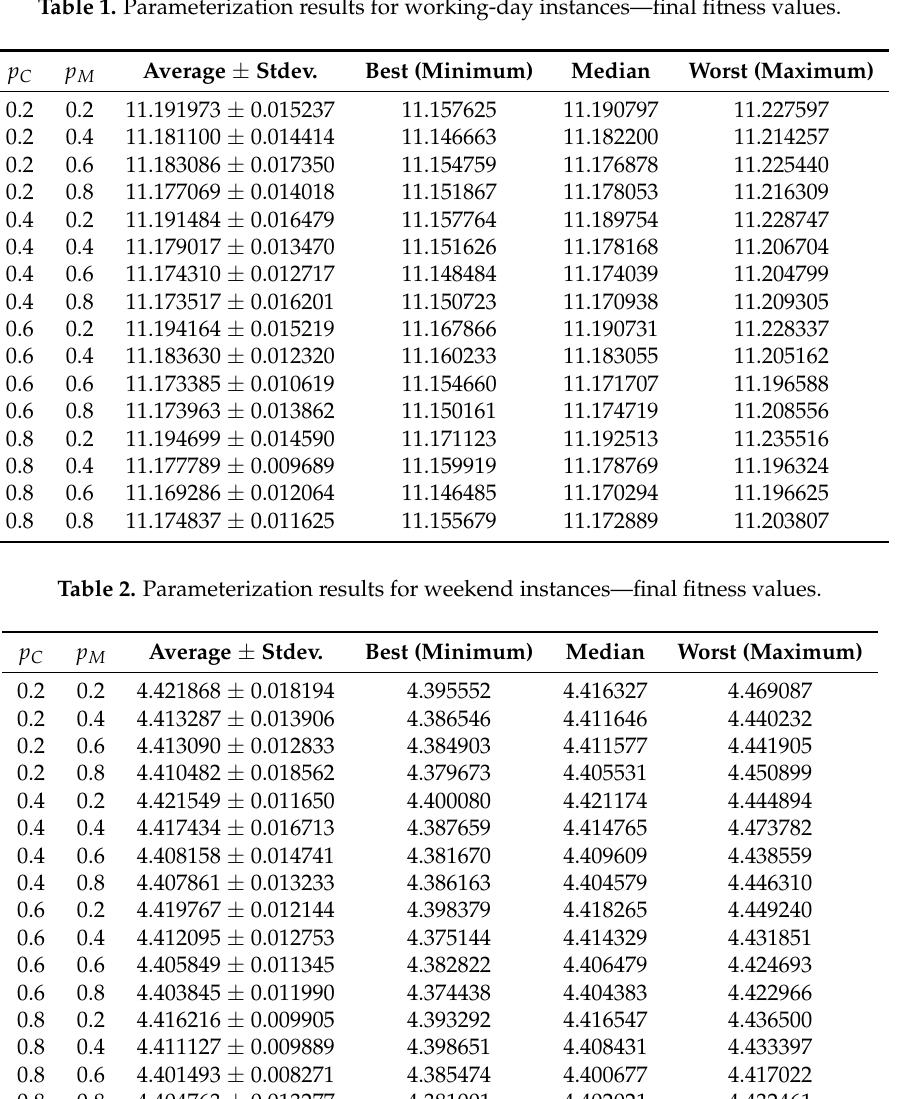
Table 1. Parameterization results for working-day instances—final fitness values.